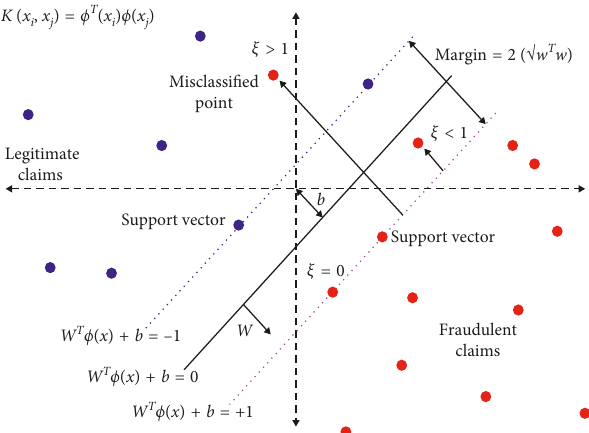
Figure 1: Standard formulation of